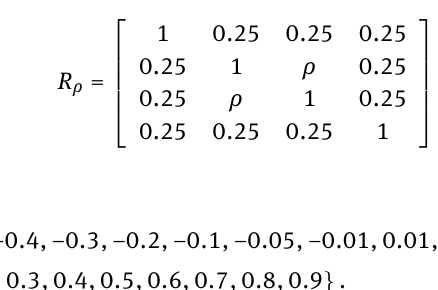
Figure 2: Impact of the dependence between X 1, t and X 1, t −1 , as measured by the average length of the prediction intervals in panel (a). The plain line gives the value of ML α N and the dashed gives the value of (cid:99) ML served values outside of prediction intervals. The circles give the results for prediction intervals based on univariate series while plus signs are for prediction intervals based on bivariate series, and the horizontal lines give the 95% confidence inter- val. For both panels, the x-axis gives the Kendall’tau between X 1, t and X 1, t −1